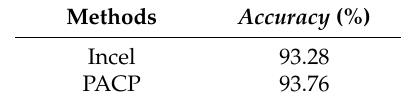
Table 3. Performance of two methods. Table 4. Result of comparison between different values.